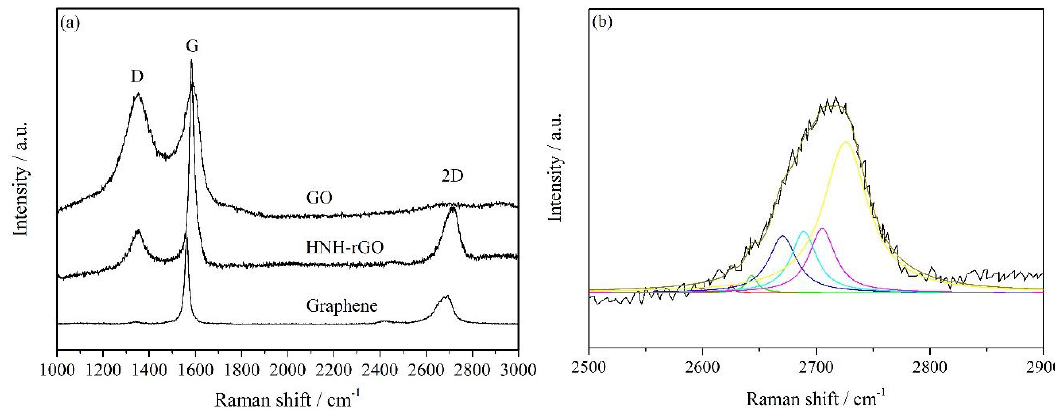
Figure 5. The Raman spectroscopy of G, GO and HNH-rGO ( a ) and the 2D peak of HNH-rGO ( b ).